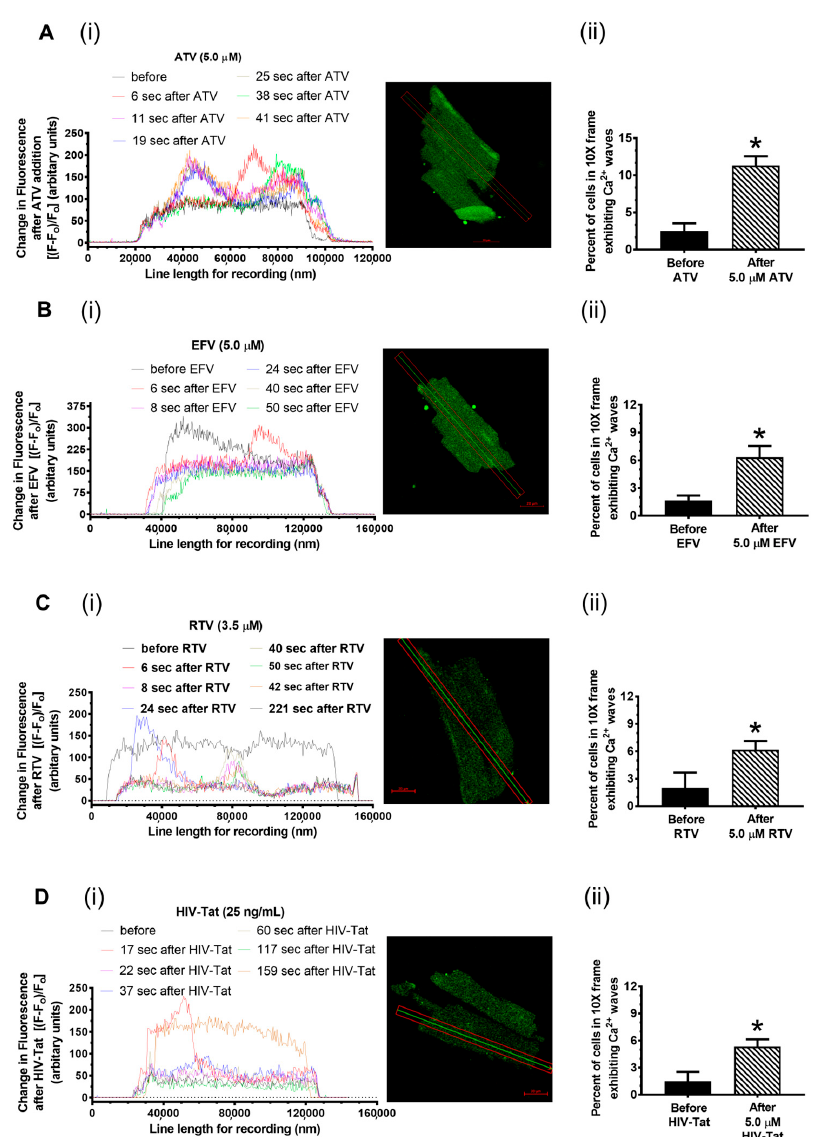
Figure 2. Time-dependent changes in intracellular Ca 2+ in primary rat ventricular myocytes following the addition of a bolus dose of HIV-Tat, ATV, EFV, and RTV. For this, primary ventricular myocytes isolated from rat hearts were incubated with the Ca 2+ -sensitive Fluo-3; these were placed on the head stage of a laser confocal microscope equipped with 10 × and 40 × objectives (Zeiss Confocal LSM 710, equipped with an Argon-Krypton Laser, 25 mW argon laser, 2% intensity, Thornwood, NJ, excitation wavelength 488 nm, and emission wavelengths of 515 nm). Panel A(i) shows the time- dependent changes in intracellular Ca 2+ from a representative rat ventricular myocyte when exposed to ATV (5.0 µ M). Panel A(ii) shows the mean ± SD for >40 cells in the four separate chambers before and after ATV treatment. Panel B(i) shows the time-dependent changes in intracellular Ca 2+ from a representative rat ventricular myocyte when exposed to EFV (5.0 µ M). Panel B(ii) shows the mean ± SD for >40 cells in the four separate chambers before and after EFV treatment. Panel C(i) shows the time-dependent changes in intracellular Ca 2+ from a representative rat ventricular myocyte when exposed to RTV (5.0 µ M). Panel C(ii) shows the mean ± SD for >40 cells in the four separate chambers before and after RTV treatment. Panel D(i) shows the time-dependent changes in intracellular Ca 2+ from a representative rat ventricular myocyte when exposed to HIV-Tat (25 ng/mL). Panel D(ii) shows the mean ± SD for >40 cells in four separate chambers before and after HIV-Tat treatment. * denotes significantly different ( p < 0.05) from the control (before the addition of the